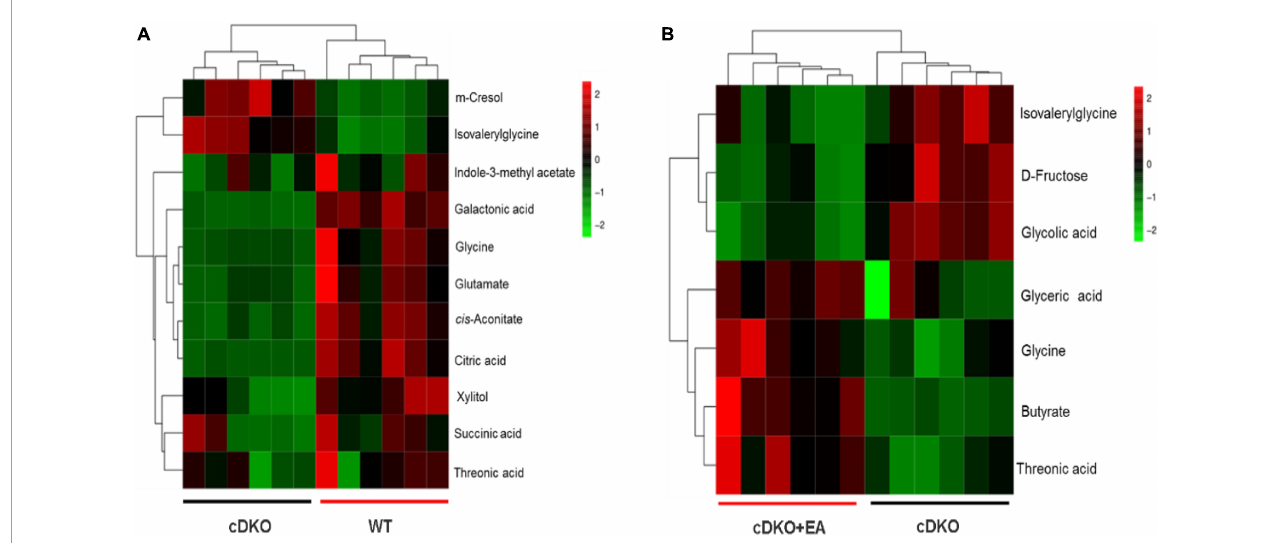
FIGURE3 Heat map of the differential metabolites in the cDKO group and the WT group (A) , and the cDKO group and the cDKO + EA group (B) , N = 6.